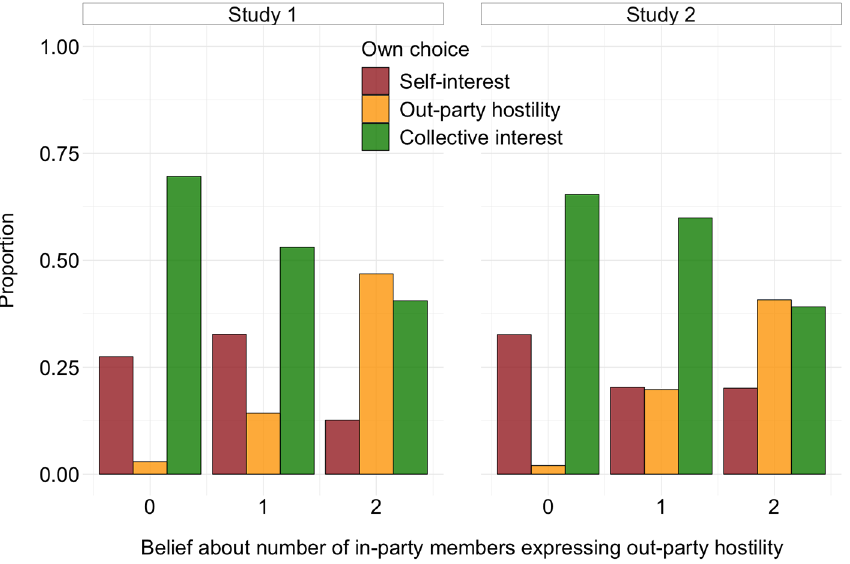
Figure 5. Proportion of choices in the IPD-MD game as a function of subjects’ beliefs about the number of in-party members expressing out-party